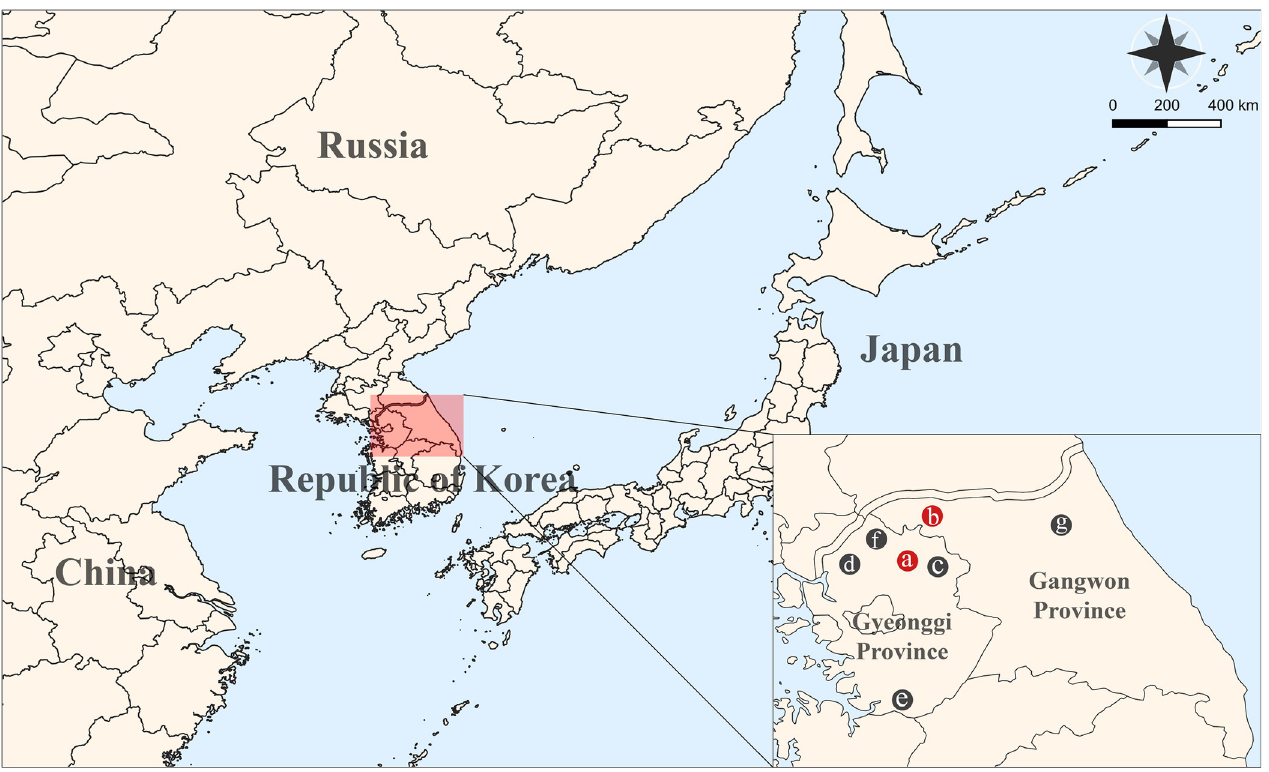
Fig 1. Geographical locations of tick collection in Gyeonggi and Gangwon Provinces, Republic of Korea, during 2019–2020. The red circles indicate the severe fever with thrombocytopenia syndrome virus (SFTSV) RNA positive sites: a, Pocheon in Gyeonggi Province; b, Cheorwon in Gangwon Province. The black circles show the regions where no SFTSV RNA was detected: c, Gapyeong; d, Paju; e, Pyeongtaek; and f, Yeoncheon in Gyeonggi Province; g, Inje in Gangwon Province. The geographic map was created by a Quantum Geographical Information System 3.10 software for Mac and modified using Adobe Illustrator CC 2019.